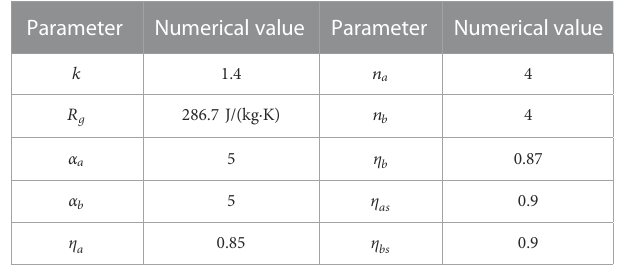
TABLE 2 Parameter information of LAES.